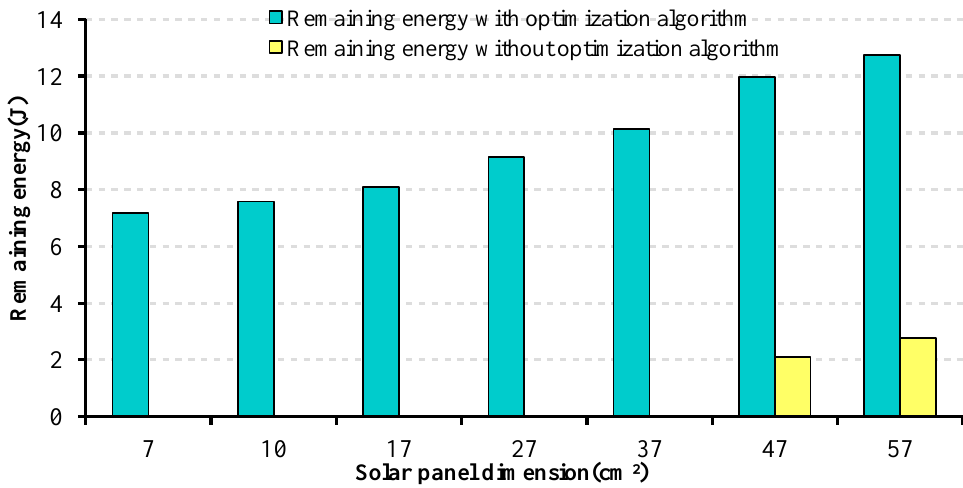
Figure 21. Impact of the proposed algorithm on the selection of the solar